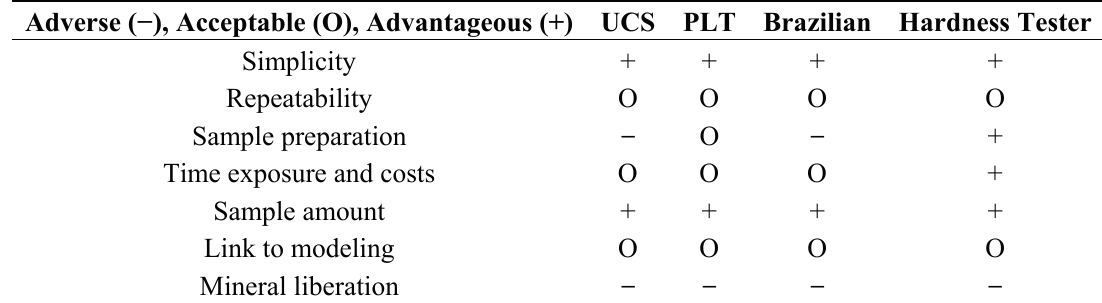
Table 1. Rock mechanical